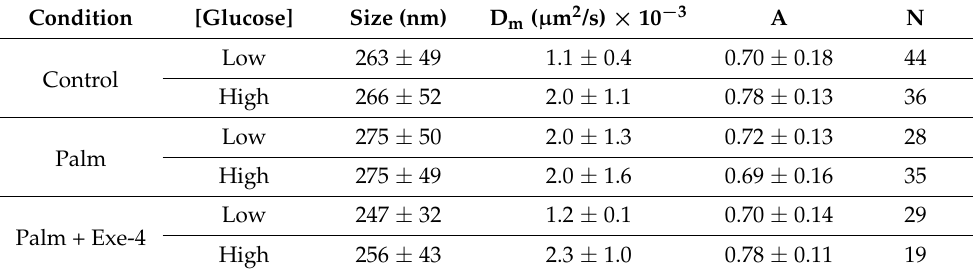
Table 2. i MSD-extracted parameters for dispersed HI exposed to Ctrl medium, Palm and Palm + Exe. Condition [Glucose]